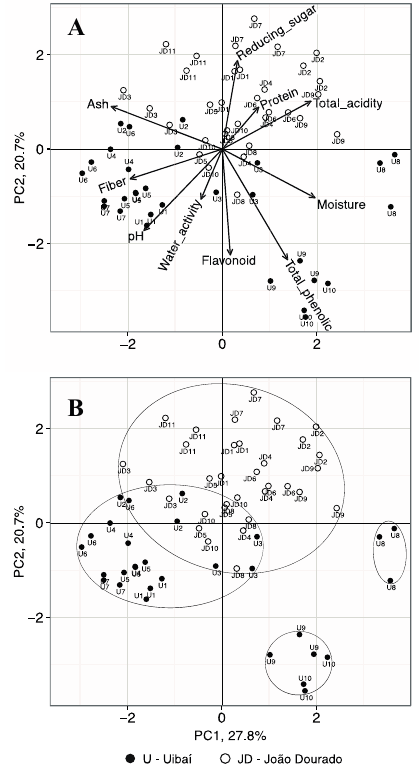
Figure 3. Representation of the first two principal components for all pollen samples distinguishing the place of origin by using different markers: plot ( A ) includes loadings of the original variables; plot ( B ) includes possible outline grouping